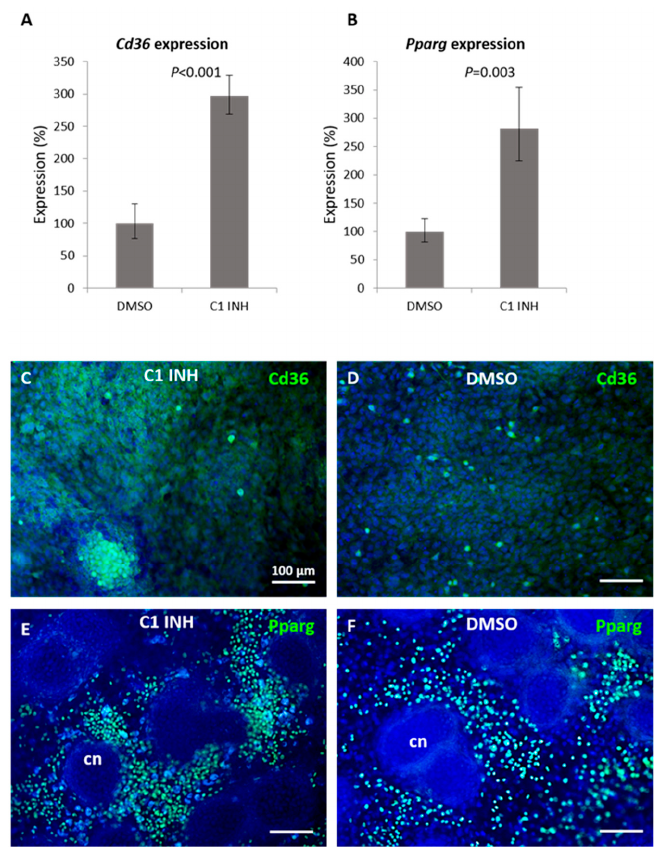
Figure 3. RNA expression of Cd36 and Pparg and respective protein detection after caspase-1 inhibition in micromass cultures. Expression of Cd36 ( A ) and Pparg ( B ) in micromass cultures after 6 days of cultivation with caspase-1 inhibitor. Immunofluorescent detection of Cd36 and Pparg in micromass cultures after 6 days of cultivation with caspase-1 inhibitor ( C , E ) and in control (DMSO) group ( D , F ). The positive fluorescent signal is green, nuclei counterstained by DAPI are blue. cn (cartilage nodule). Scale bar = 100 µ